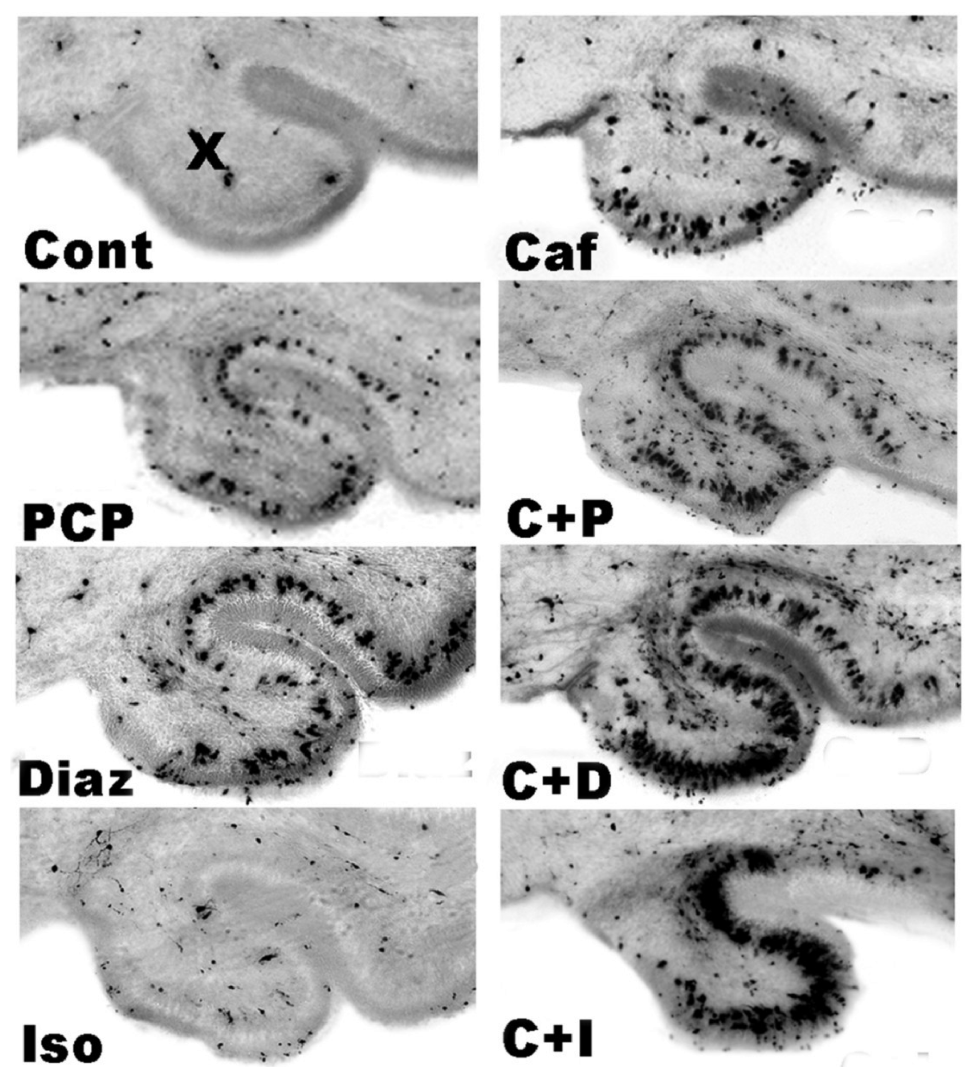
Figure 8. Neuroapoptosis in the cerebellum. These panels illustrate the neuroapoptosis response in folium 10 (X) of the infant mouse cerebellum of a control (Cont) brain, compare to brains exposed to caffeine (Caf), phencyclidine (PCP), caffeine + PCP (C + P), Diazepam (Diaz), caffeine + diazepam (C + D), Isoflurane (Iso) or caffeine + isoflurane (C + I). The large dark profiles in curvilinear display are apoptotic Purkinje cells. The smaller dark profiles are in a migratory status and are of uncertain identity